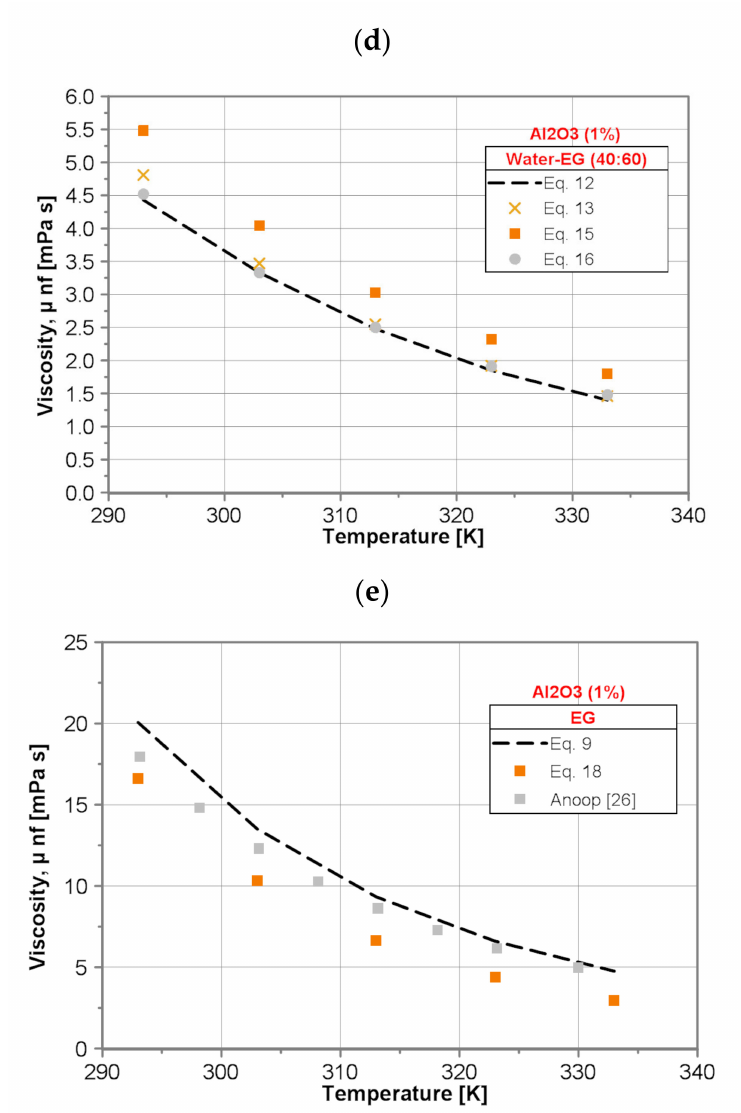
Figure 3. Comparison of dynamic viscosity of the tested nanofluids with 1% nanoparticle mass concentration: ( a ) water / Al 2 O 3 , ( b ) water / EG (60:40) / Al 2 O 3 , ( c ) water / EG(50:50) / Al 2 O 3 , ( d ) water / EG (40:60) / Al 2 O 3 and ( e ) EG-Al 2 O